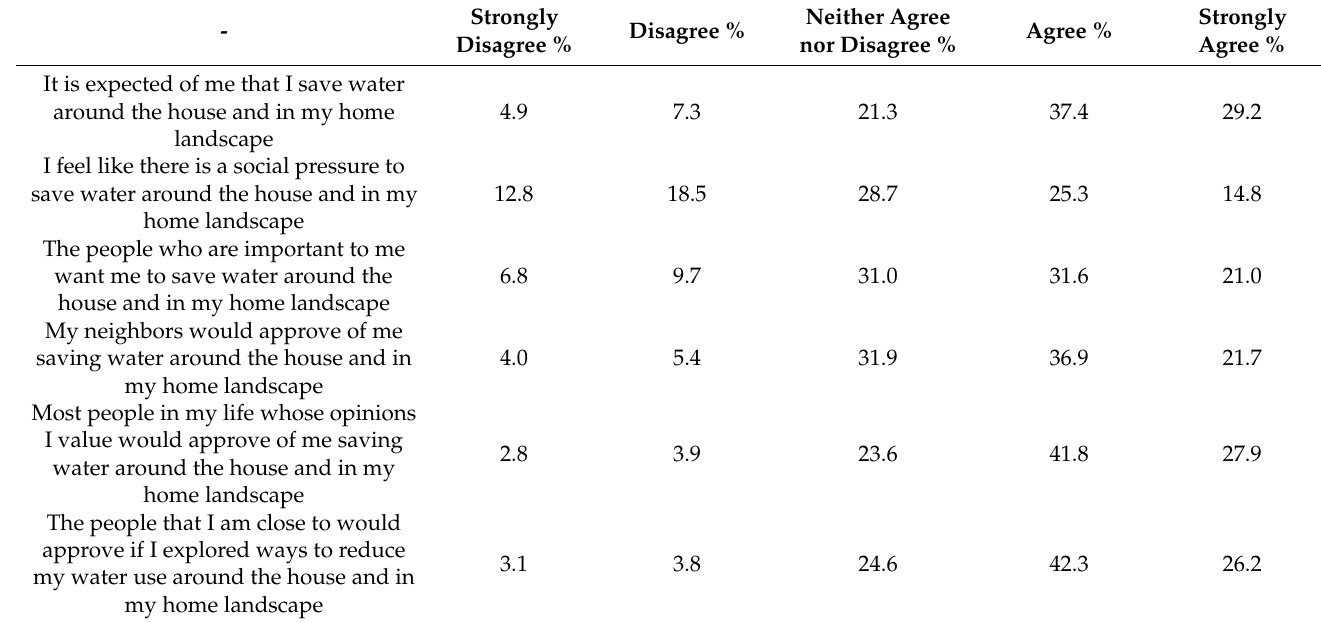
Table 2. Respondents’ subjective norms around water conservation (N = 1049).